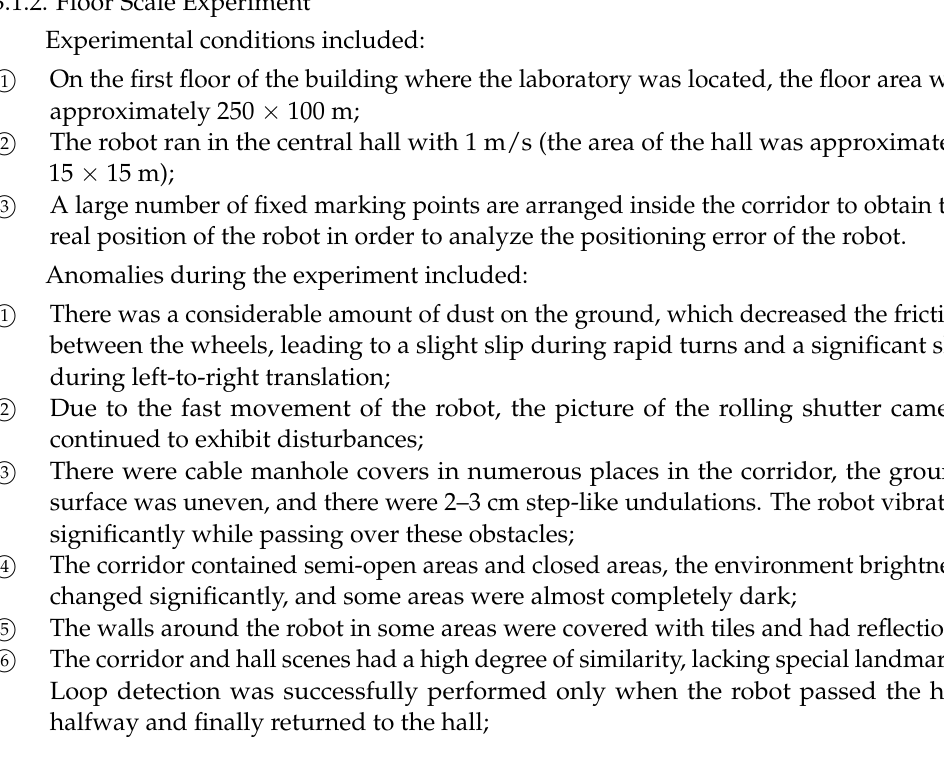
Figure 4. Path of pose measurement at room scale. Table 1. Room-scale pose measurement results.